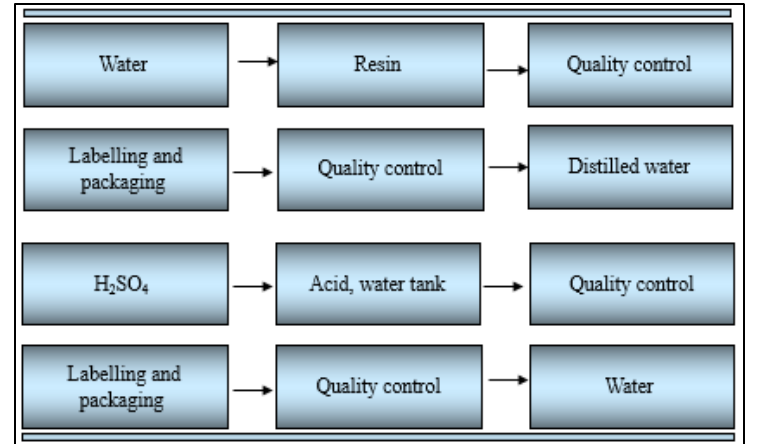
Figure 3: The layout of units of distilled water and acidic water 28% (two down diagrams). Source: Author,